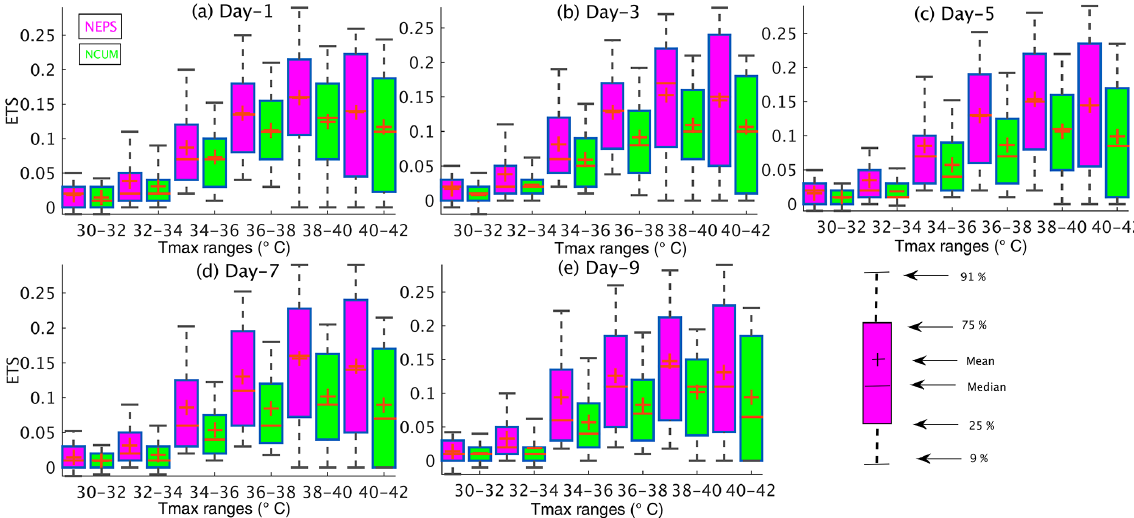
Figure 10. Box plots (a–e) for equitable threat score (ETS) for NCUM and NEPS from March to May 2016 (NCUM stands for NCMRWF unified model and NEPS stands for NCMRWF ensemble prediction system). ETS values are higher in NEPS forecasts, particularly at high temperature ranges, (>36 ◦ C) and for all lead times compared to NCUM forecasts, suggesting improved performance of NEPS at higher temperature ranges.